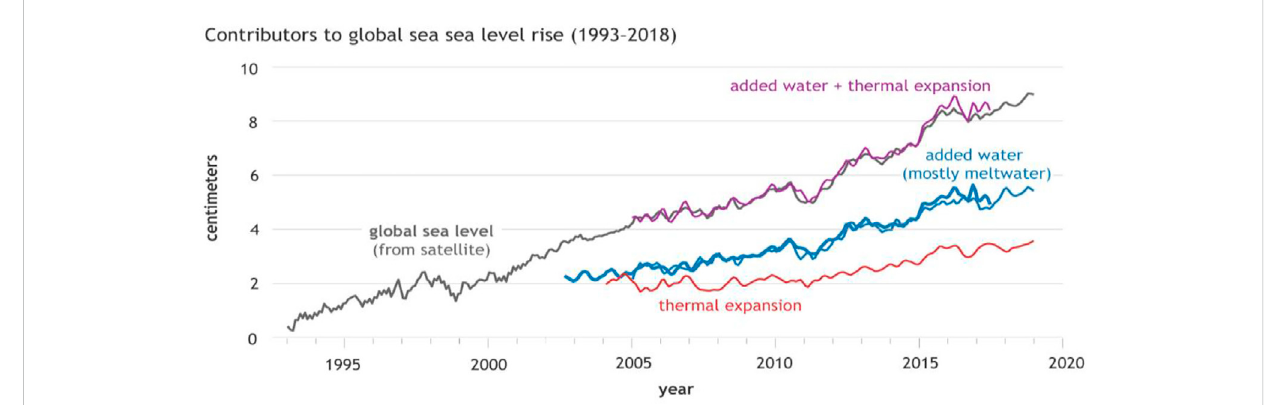
FIGURE 4 Rise in global sea levels as seen through satellite altimeters, Period: 1993 – 2018. Source: NOAA.